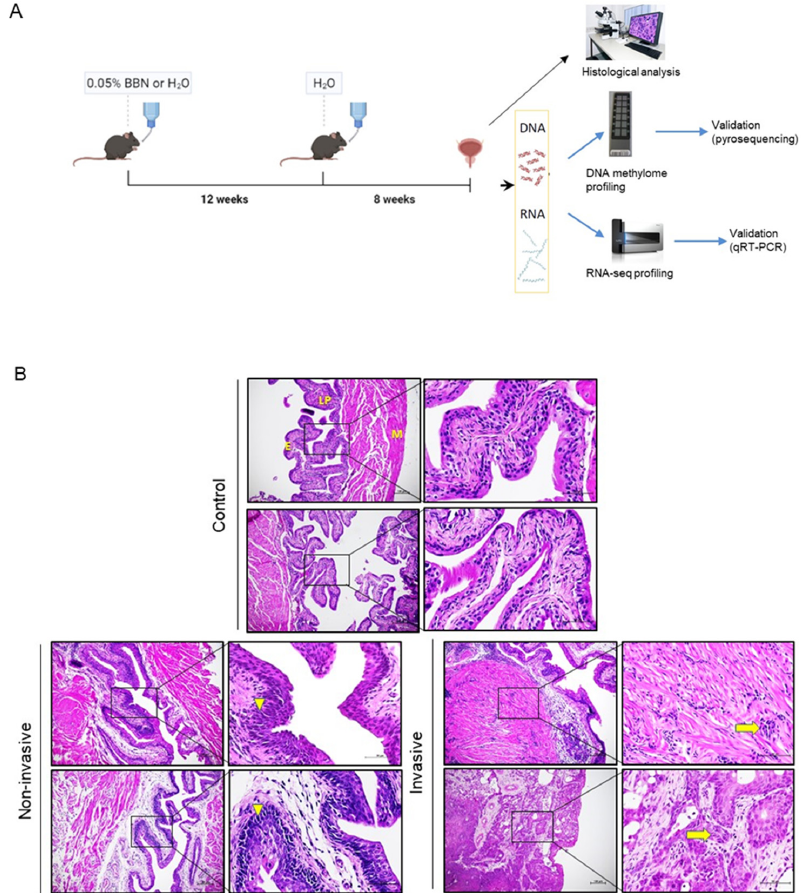
Figure 1. BBN treatment and bladder cancer morphology. ( A ) A schematic representation of BBN treatment (created with BioRender.com) and flow through experiments. ( B ) Representative images of patho-histological classifications of hematoxylin–eosin-stained murine bladders of control group (E, epithelium; LP, lamina propria; M, muscle) and after BBN exposure; non-invasive tumors carcinoma in situ (arrowheads indicate randomly arranged cells and compact, large, pleomorphic nuclei with multiple nuclei) and invasive (arrows point to urothelial cells invading the muscle) tumors. Images were taken at 400× and 600× magnifications.